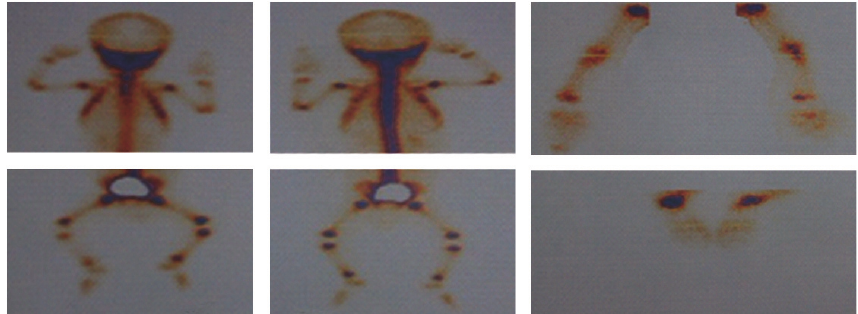
Figure 3: Osteomyelitis of the left ankle, right elbow, and right wrist.